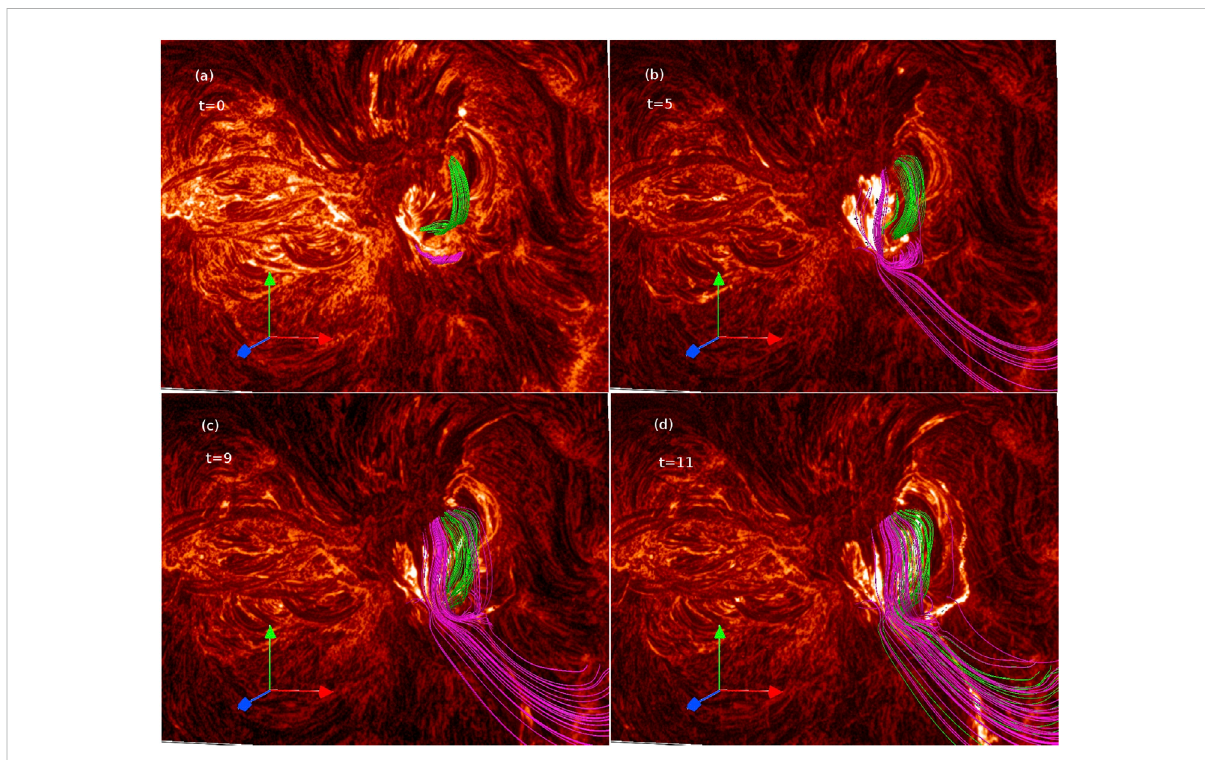
FIGURE 8 The fi gure showsthedynamicsofthe fl uxroperepresenting the fi lament (ingreen)alongwiththemagenta-coloredrope[panel (A) ].The fi gure is overlaid with the 304 Å images. Notably, the green-colored rope shows a few dynamical changes until t = 9 [panels (B and C) ]] and starts reconnecting after that [panel (D) ]]. Also see Supplementary Video S2 for a high-cadence dynamics of the